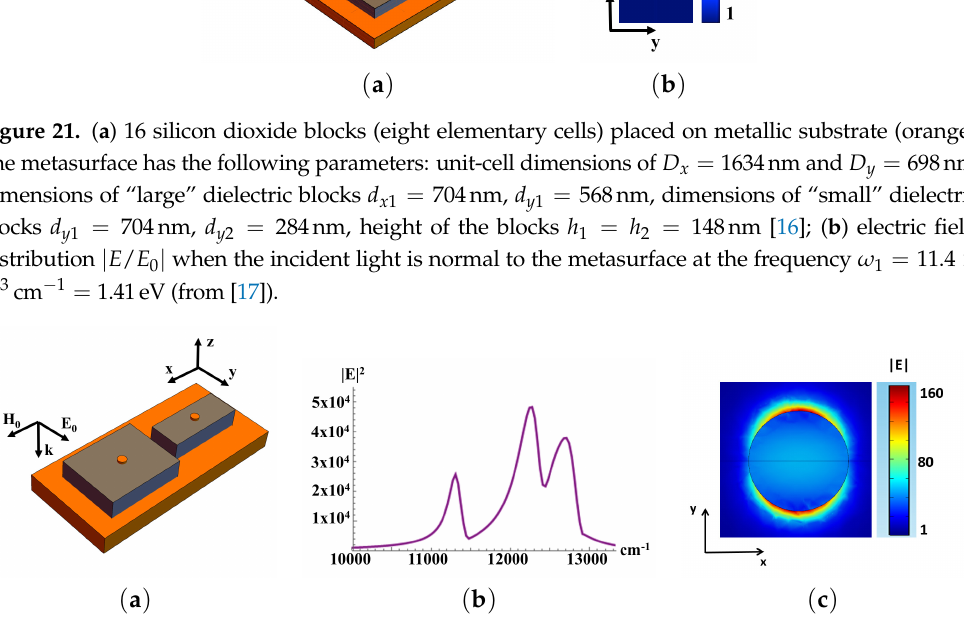
Figure 22. ( a ) single elementary cell of metal-dielectric substrate with gold nanodisks (orange color) placed on each of dielectric cuboids (gray), geometrical parameters are: lattice unit dimensions of D x = 1634nm, D y = 698nm, dimensions of dielectric resonators are d x 1 = d x 2 = 704nm and d y 1 = 568nm, d y 2 = 284nm, height of the resonators is h = 148nm. The parameters of the top gold disk are d c = 50nm, aspect ratio h c / d c = ( 1/14 ) ; ( b ) electric field enhancement | E / E 0 | 2 as function of wavenumber; gold disks are placed in the center of the top surface of dielectric cuboids. ( c ) electric field distribution | E / E 0 | over the gold disk. The metasurface is illuminated by light with an amplitude E 0 and a wavelength of 785nm , the light is incident normal to the metasurface (from